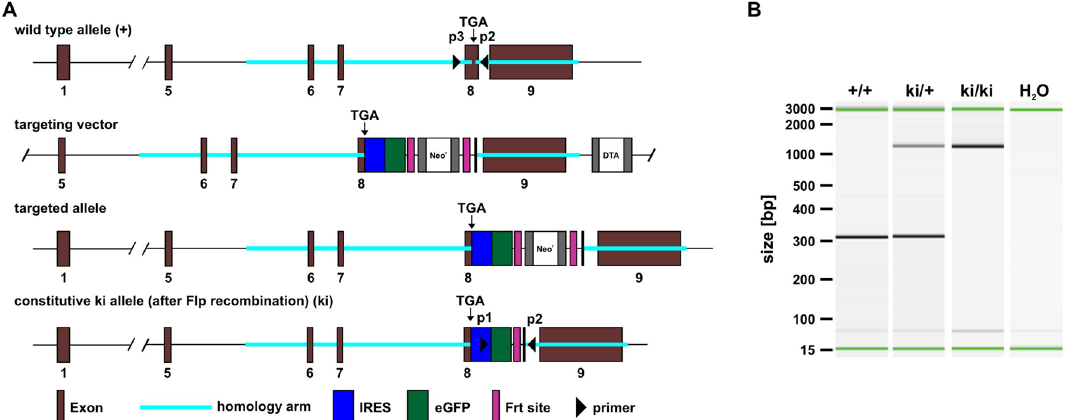
Figure 1. Generation and characterization of Gnai3 -iresGFP reporter mice. ( A ) Gene targeting strategy to generate the Gnai3 -iresGFP mouse line. In wild-type animals the Gnai3 gene is localized on chromosome 3 and consists of nine exons. The stop codon for Gnai3 transcription is localized in exon 8. The targeting vector contained exon 5 to exon 9, two homology arms, an internal ribosomal entry site (IRES) directly inserted behind the TGA stop codon for Gα i3 in exon 8, the cDNA coding for GFP, a Neo r cassette flanked by two Frt sites and a diphteria toxin A (DTA) cassette outside the second homology arm. For positive selection the neomycin resistance (Neo r ) was used, whereas the expression of DTA guaranteed the cell death upon random integration. Following homologous recombination, the targeting vector has been integrated at the respective position in the targeted allele. Finally, after Flp recombination, a constitutive ki allele had been generated. ( B ) Representative PCR analysis from ear biopsies of wild-type (+/+), heterozygous (+/ki) and homozygous knock-in (ki/ki) mice. The 300 bp fragment represents the wild-type, amplification of the knock-in fragment results in a 1200 bp product. H 2 O was used as negative control.